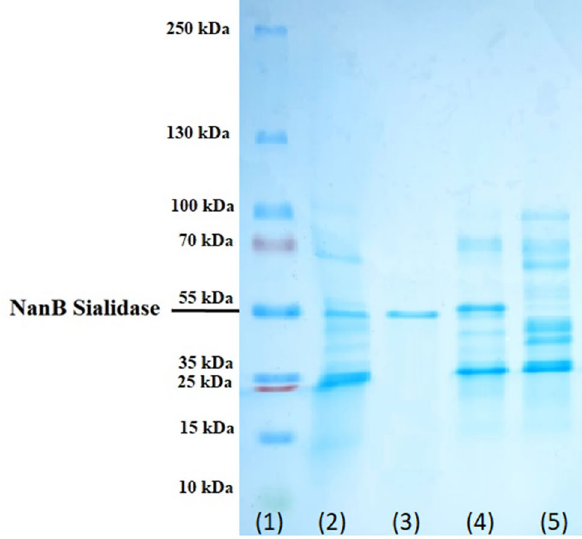
Figure 6. Results of SDS Page on protein at each stage of NanB sialidase Pasteurella multocida B018 purification. (1) Markers; (2) crude sel of Pasteurella multocida before chloroform method; (3) protein after Affinity chromatography; (4) protein after anion exchange chromatography; (5) initial protein supernatant crude sialidase.